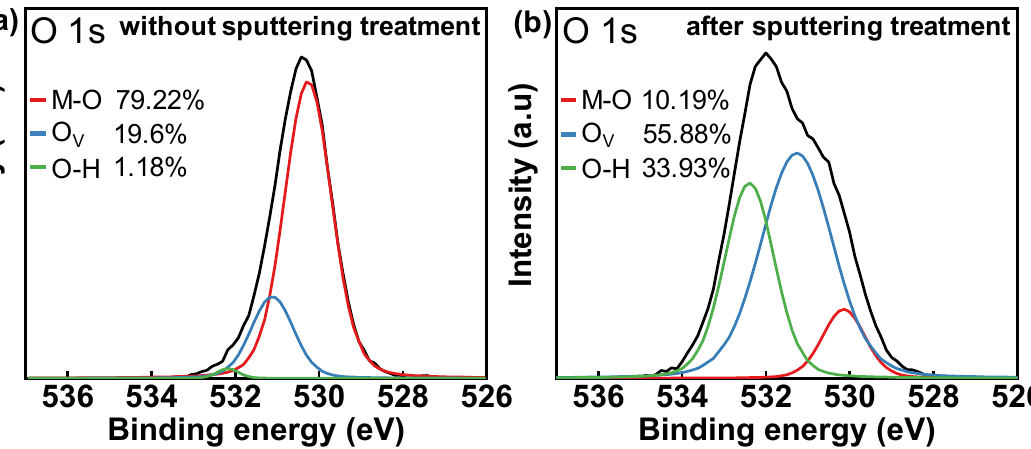
Figure 3. XPS spectra of IGZO films showing O 1s peaks in different states. ( a ) Without sputtering treatment. ( b ) After sputtering treatment.